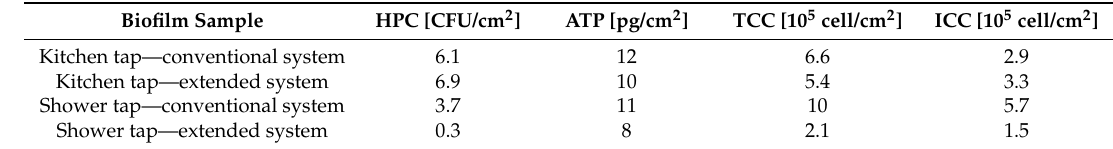
Table 1. Biofilm characteristics determined by HPC, ATP and FCM measurements from-kitchen and shower tap in conventional and extended systems.